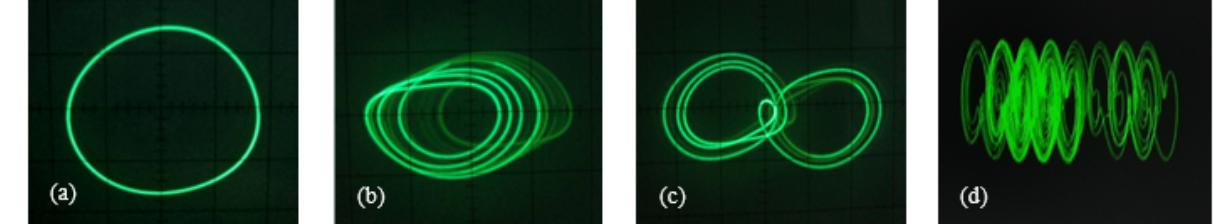
Figure 14. Experimental observation when ( a ) Rc = 12.5 k Ω ; ( b ) Rc = 9.1 k Ω ; ( c ) Rc = 8 k Ω ; ( d ) Rc = 5.6 k Ω .